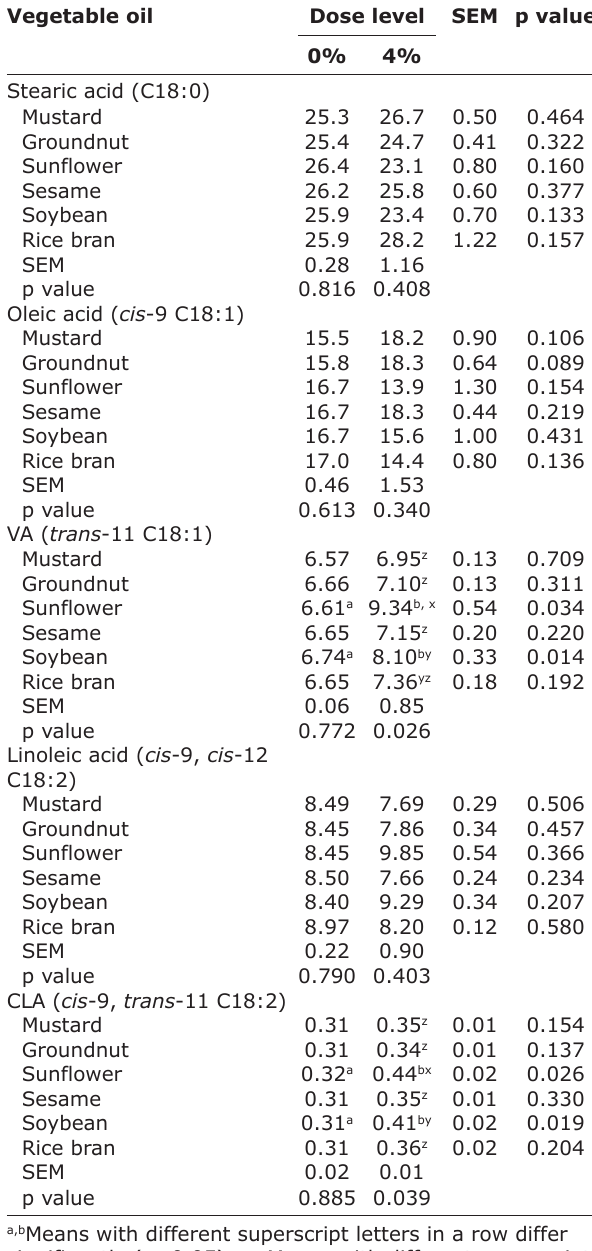
Table-4: Effect of vegetable oil supplementation on FA profile (% of total FAs) in the rumen fluid after 24 h of incubation. Vegetable